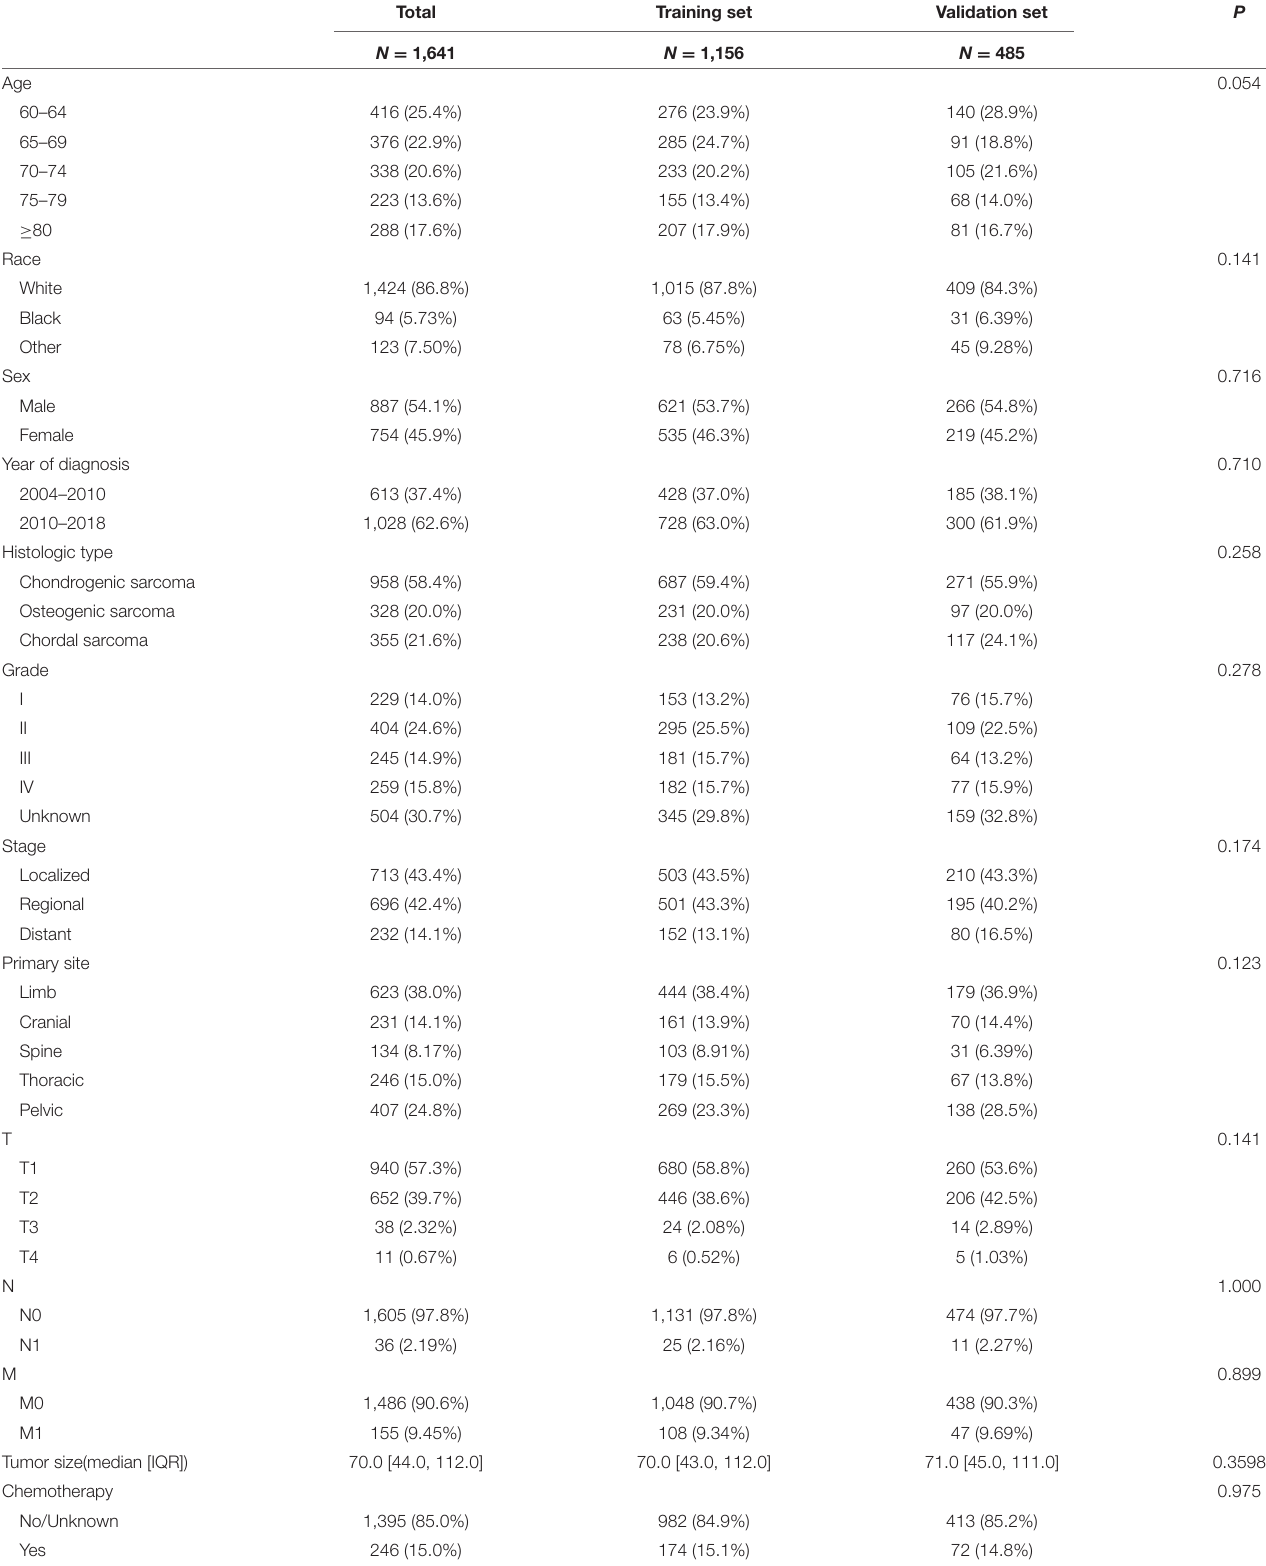
TABLE 1 | Clinicopathological characteristics of elderly patients with